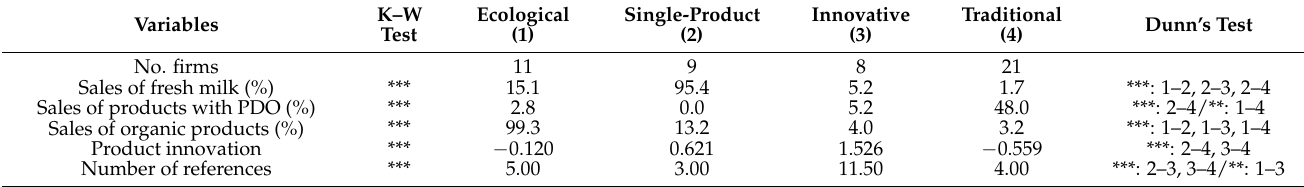
Table 4. Variables used in cluster analysis to identify value-creating